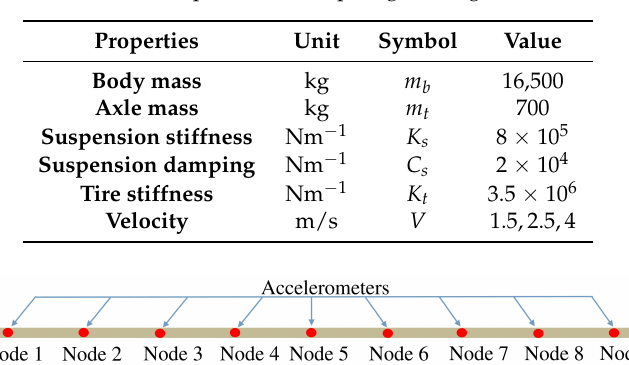
Table 3. Properties of the sprung moving mass.